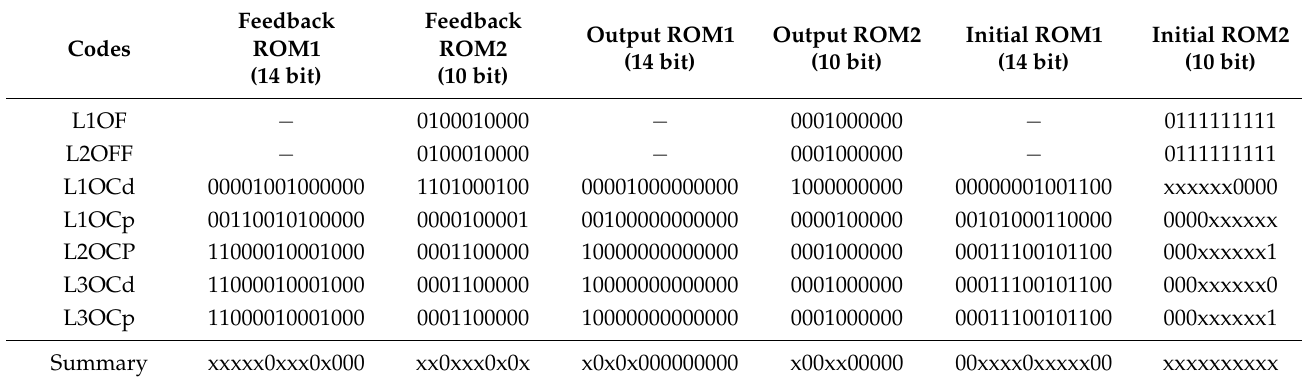
Table 4. The fixed parameters of code generators for GLONASS signals.